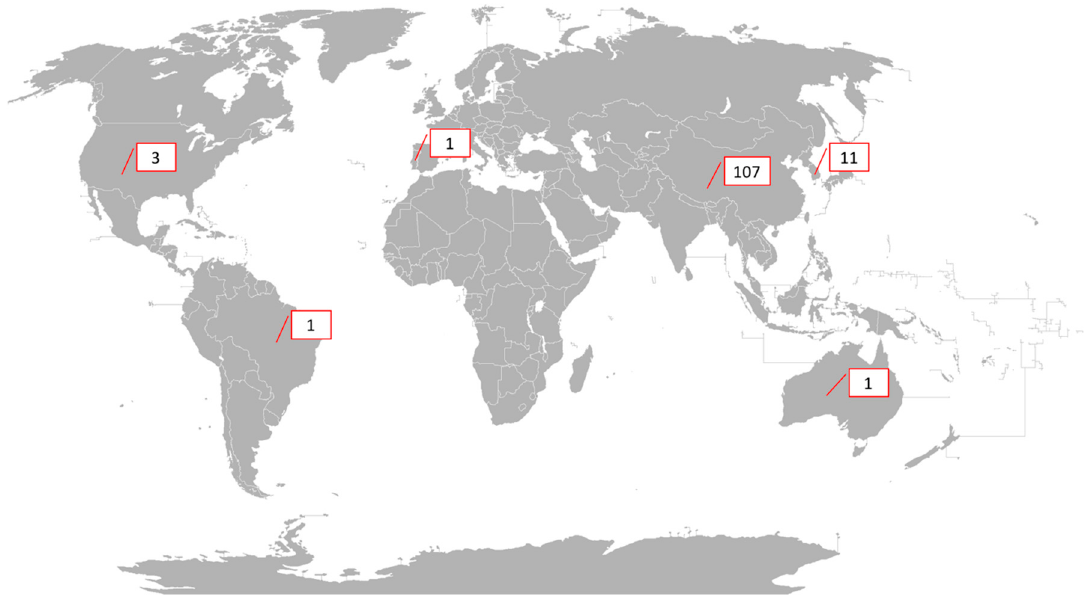
Figure 1. Global distribution of published SRs protocols on acupuncture with quotations. Figure adapted from Fobos92’s world map with CC BY-SA 3.0 license.